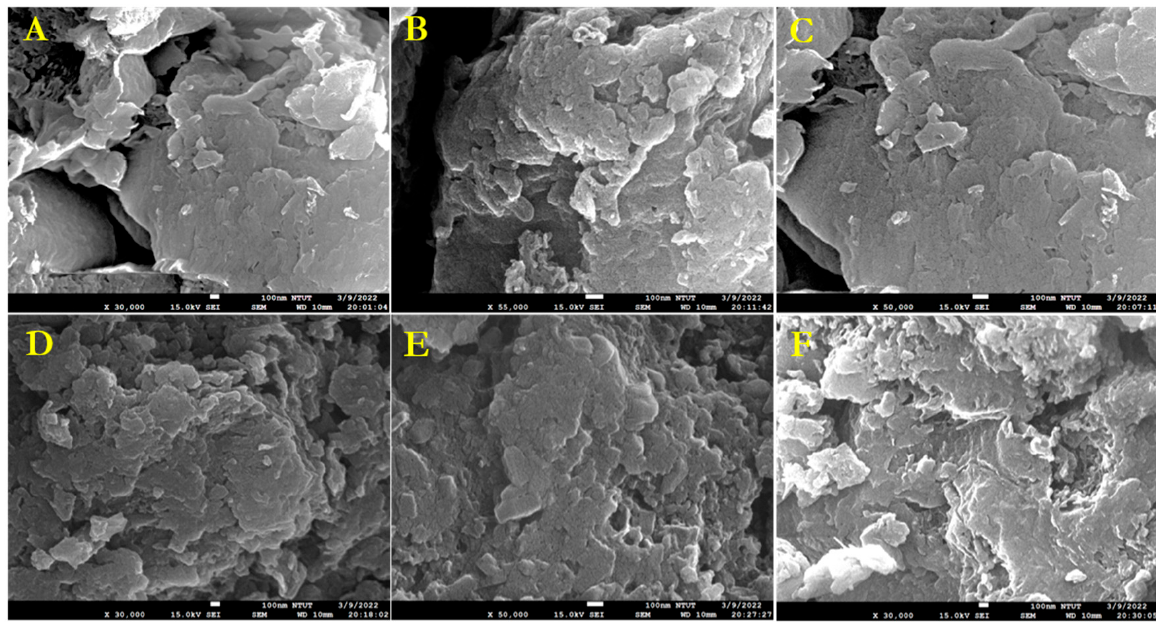
Figure 2. Field-emission scanning electron microscopic (FE-SEM) images of pure g-C 3 N 4 ( A – C ) and g-C 3 N 4 –SO 3 H ( D – F ).